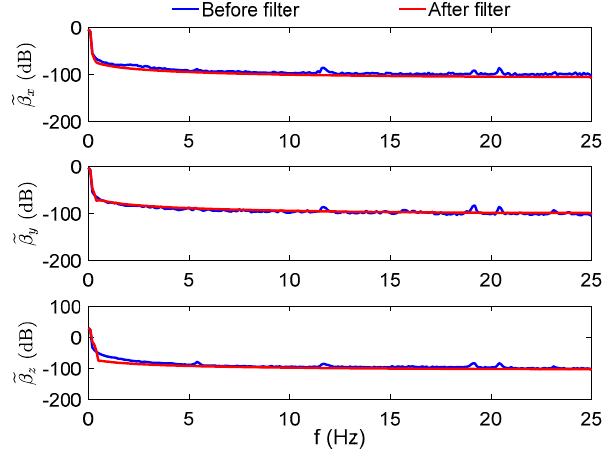
Figure 4. The power spectrum of the observation vector.